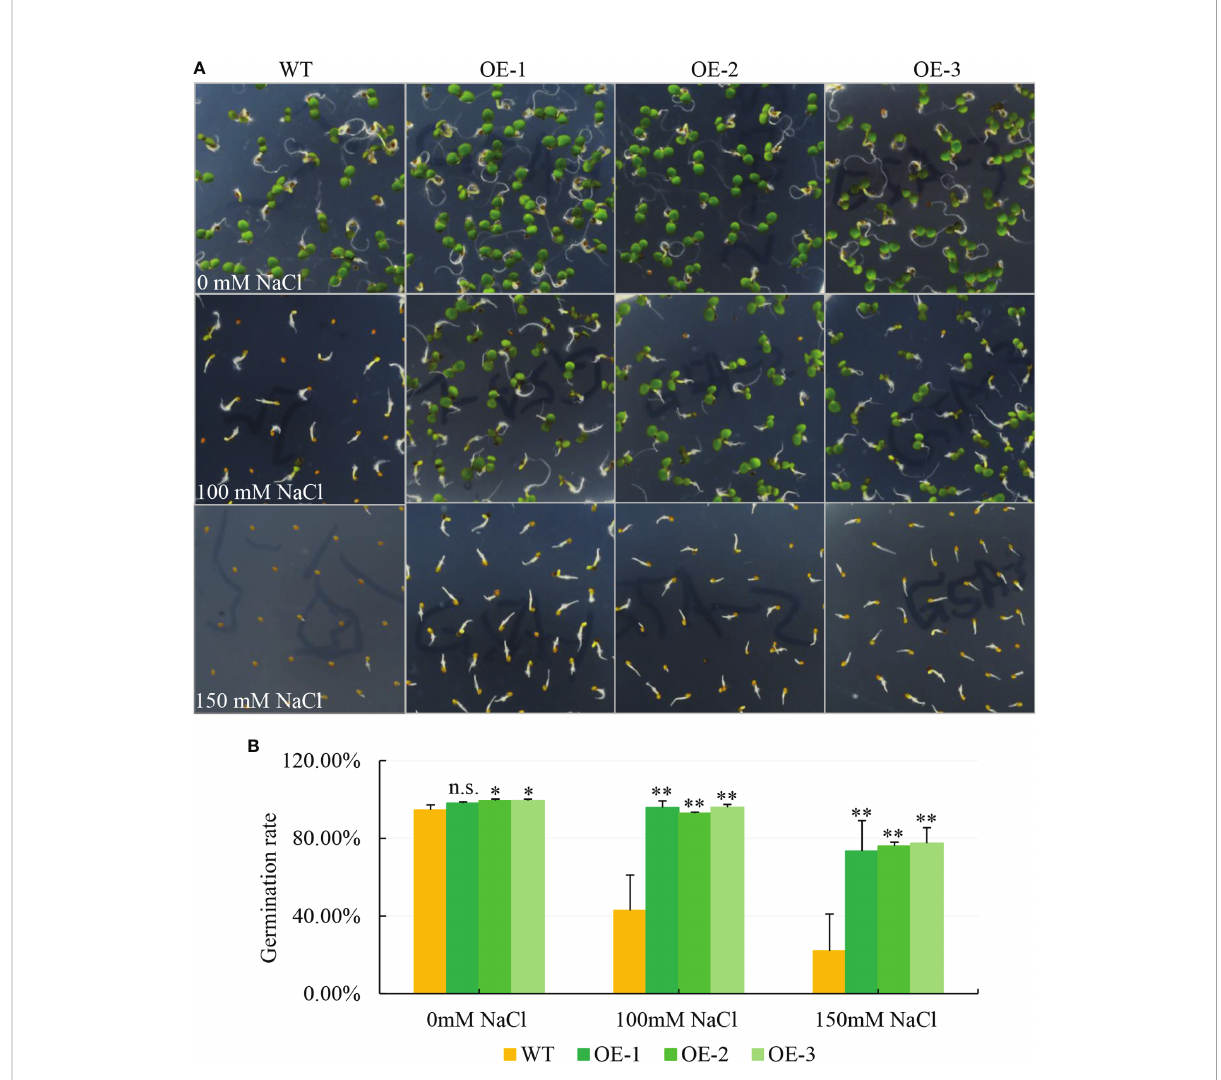
FIGURE 1 NbCIPK25 overexpression promotes the germination rate and growth of Arabidopsis on salt medium. (A) The phenotype of seed germination under various salt condition. WT mean wild type Col Arabidopsis . OE-1, 2, 3 represent three independent transgenic lines of NbCIPK25 overexpression. 180 seeds in total per line were used in this experiment. The seeds sterilized with 1% sodium hypochlorite for 15 min were planted on 1/2 MS containing 0, 100 or 150 mM NaCl, respectively. (B) Statistical analysis for the germination rate of WT and transgenic seeds grown under the indicated NaCl concentration. Data represent means ± standard deviation (SD) from three biological replicates, statistics was analyzed by one-way ANOVA test, ‘ * ’ p < 0.05, ‘ ** ’ p < 0.01, n.s., not signi fi